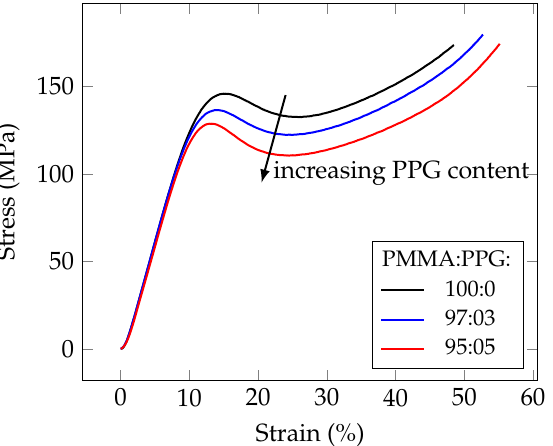
Figure 4. Comparison of the stress–strain responses during the uniaxial compression of PMMA, plasticized with various amounts of PPG ( M n 446 ) , shows that increase in PPG content leads to decrease of yield strength.